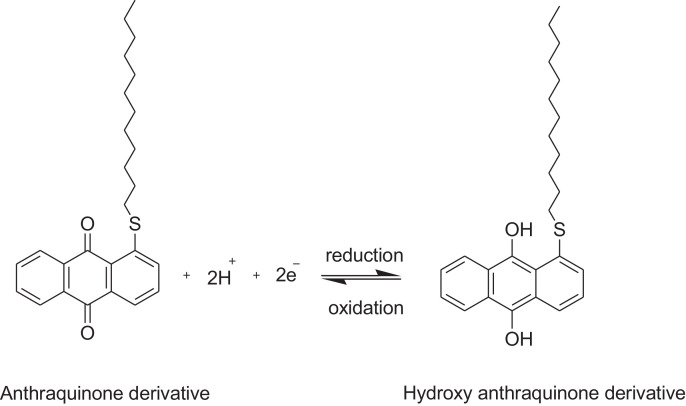
Electrochemical redox reaction of anthraquinones [3].